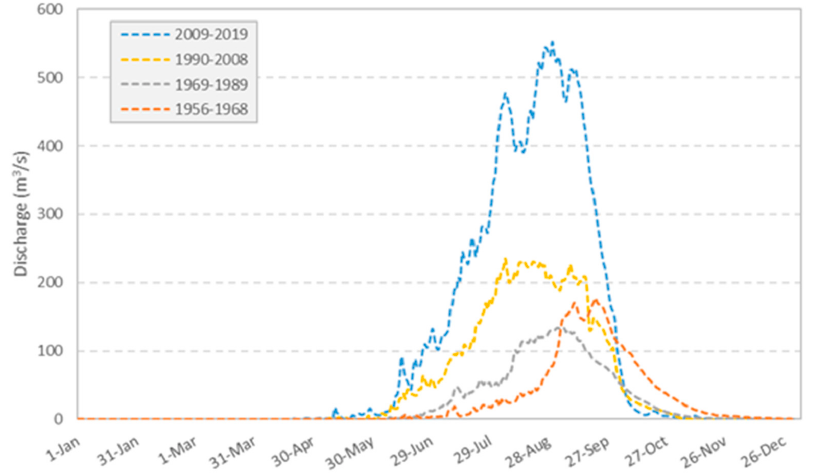
Figure 2. Comparison of Sirba River average hydrographs, over the four hydrological periods, at Garbey Kourou hydrometer.